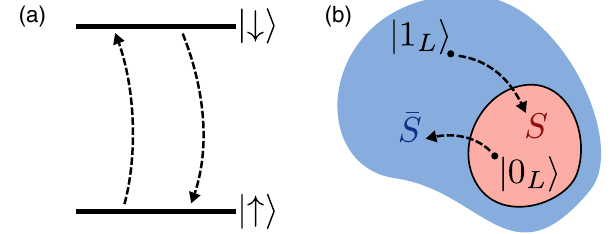
FIG. 1. Cartoon illustrating qubit readout errors. (a) In a two- level system, qubit readout means determining the energy eigenstate of the system at time t ¼ 0 . Dashed arrows indicate incorrect assignments P ð ↑ jj ↓ iÞ and P ð ↓ jj ↑ iÞ , which may be due to detector noise or state transitions. (b) In a many-dimensional Hilbert space, reading out a single bit requires partitioning the Hilbert space into two sets containing the encoded 0 and 1 states. Instead of an energy eigenstate, membership in S or its comple- ¯ S ¼ H n S is measured. The dashed arrows now indicate the ment ¯ S jj 0 assignment errors P ð S jj 1 and P ð L iÞ L iÞ